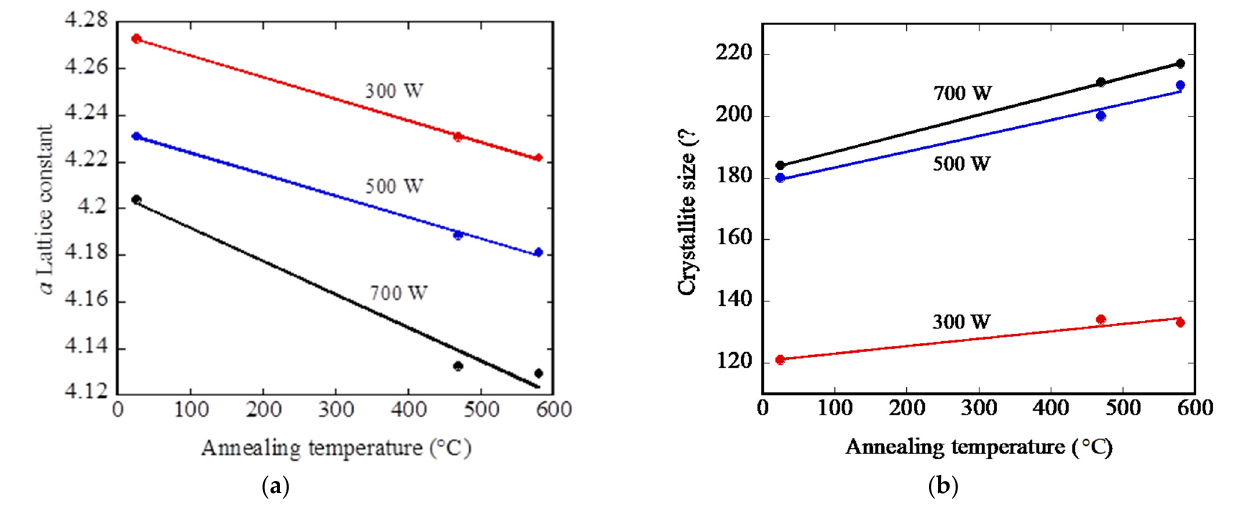
Figure 4. ( a ) Lattice constant vs. annealing T. ( b ) Crystallite size of WN x films obtained at different deposition powers before and after annealing.